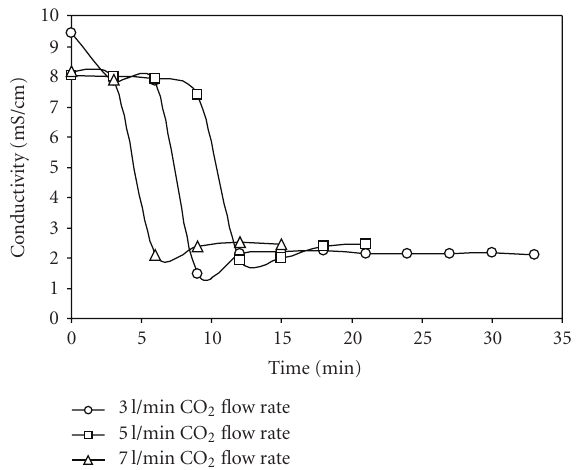
Figure 8: E ff ect of CO 2 flow rates on conductivity of reaction mix- ture (orifice diameter 4mm, 4% Ca(OH) 2 slurry concentration).